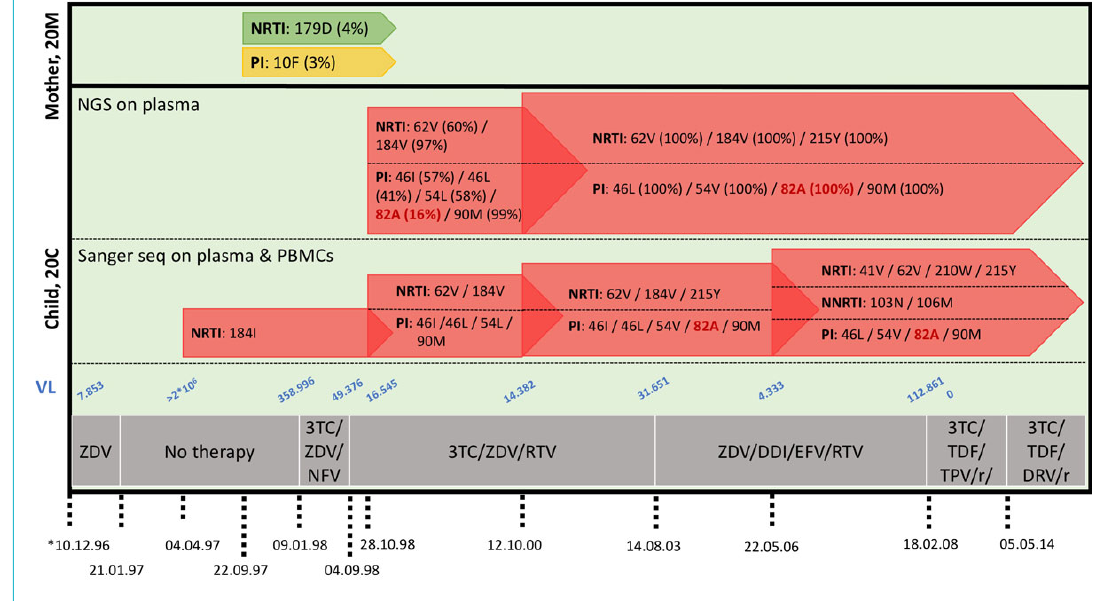
Figure 4: Deep sequencing of samples from mother-child pair 20. Comparison of Sanger sequencing and deep sequencing results of HIV-1 RNA from mother-child pair 20. Sampling dates and treatment history are indicated, as well as HIV-1 loads (copies / mL). Deep se- quencing results are additionally shown as mutation frequencies (%). No material was available from the first time point at which the reported M184I was detected.NRTI = nucleo(s/t)ide reverse transcriptase inhibitor; NNRTI = non-nucleo(s/t)ide reverse transcriptase inhibitor; PI = pro- tease inhibitor; 3TC = lamivudine; ZDV = zidovudine; DDI = didanosine; TDF = tenofovir; EFV = efavirenz; NFV = nelfinavir; DRV = darunavir; TPV = tipranavir; RTV/r = ritonavir/boosted